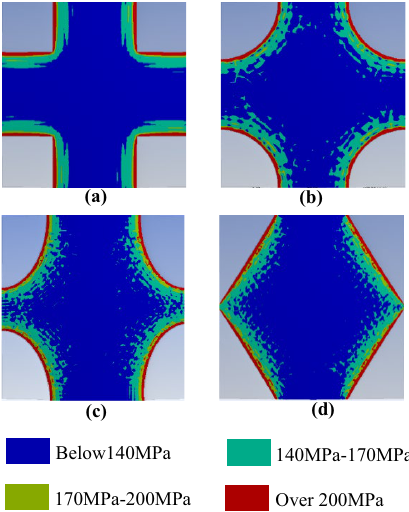
Figure 8 Contact pressure on the surface of texture units: a square texture unit, b circular texture unit, c elliptical texture unit, d rhombic texture unit